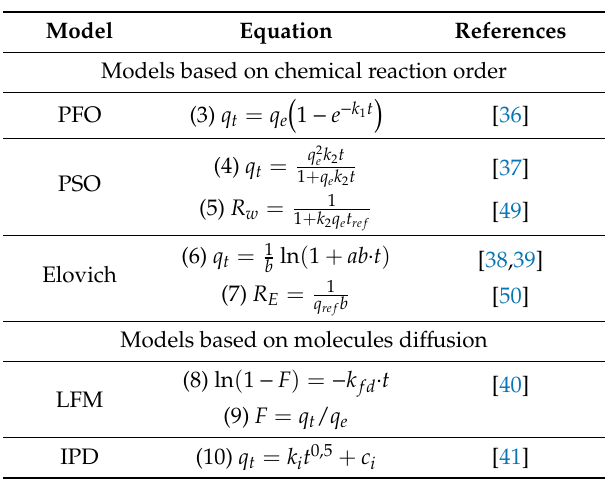
Table 1. Equations of the applied kinetic